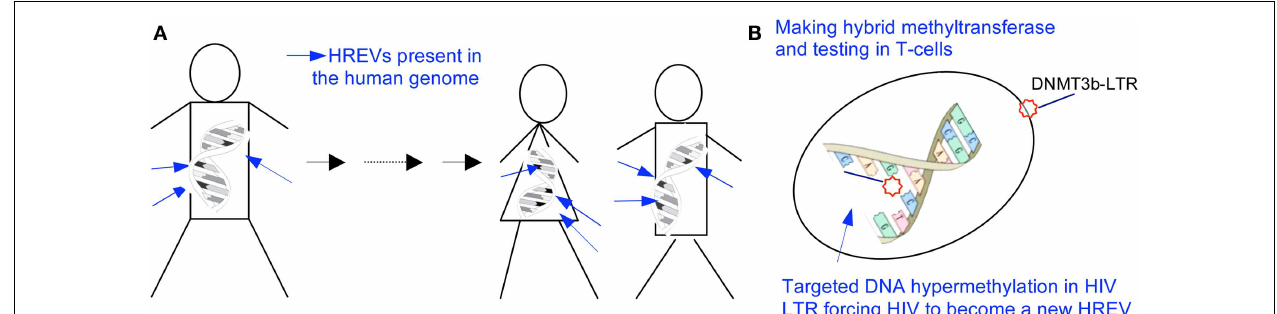
enzyme catalyzing the transfer of methyl groups to cytosines of a targeted gene to silence the gene expression in the human genome, specifically to endogenous retroviruses and transposons. LTR contains the most conserved DNA sequence in a latent HIV. DNMT3b-LTR binds to the proviral LTR by base pair affinity, in a time of either RNA transcription or DNA semi-conservative replication.The bio-molecule binding to the HIV LTR leads to a heritable, stable DNA hypermethylation at the HIV promoter (1–11, 15, 69–71, 80).